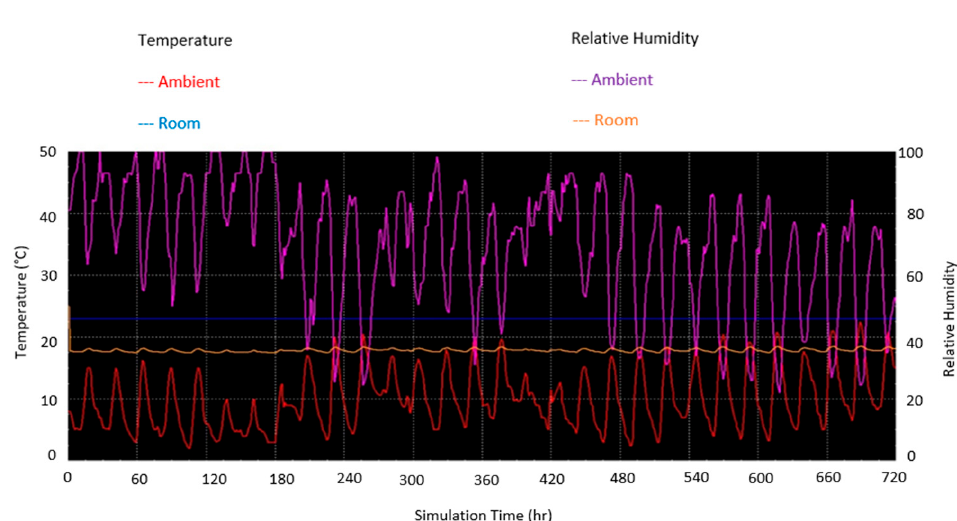
Figure 9. January simulation run for option A.